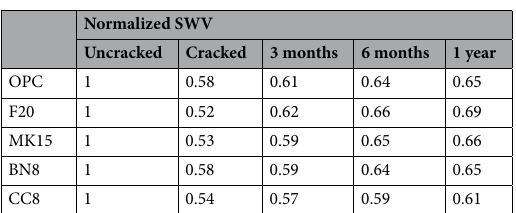
Table 5. Shear wave velocity evolution of mortar specimens exposed to cyclic T and